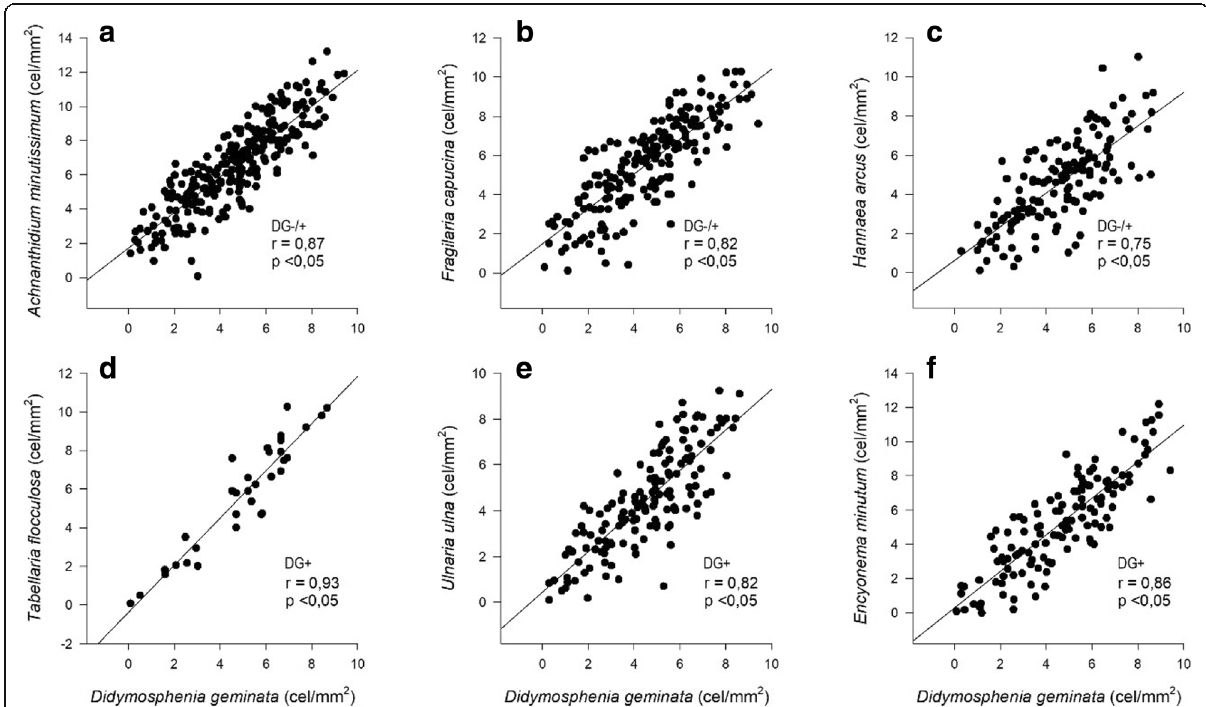
Fig. 5 Variation patterns of the density of six diatom species in relation to the density of D. geminata. ( a ) Achnanthidium minutissimun , ( b ) Fragilaria capucina , ( c ) Hannaea arcus , ( d ) Tabellaria flocculosa , ( e ) Ulnaria ulna and ( f ) Encyonema minutum